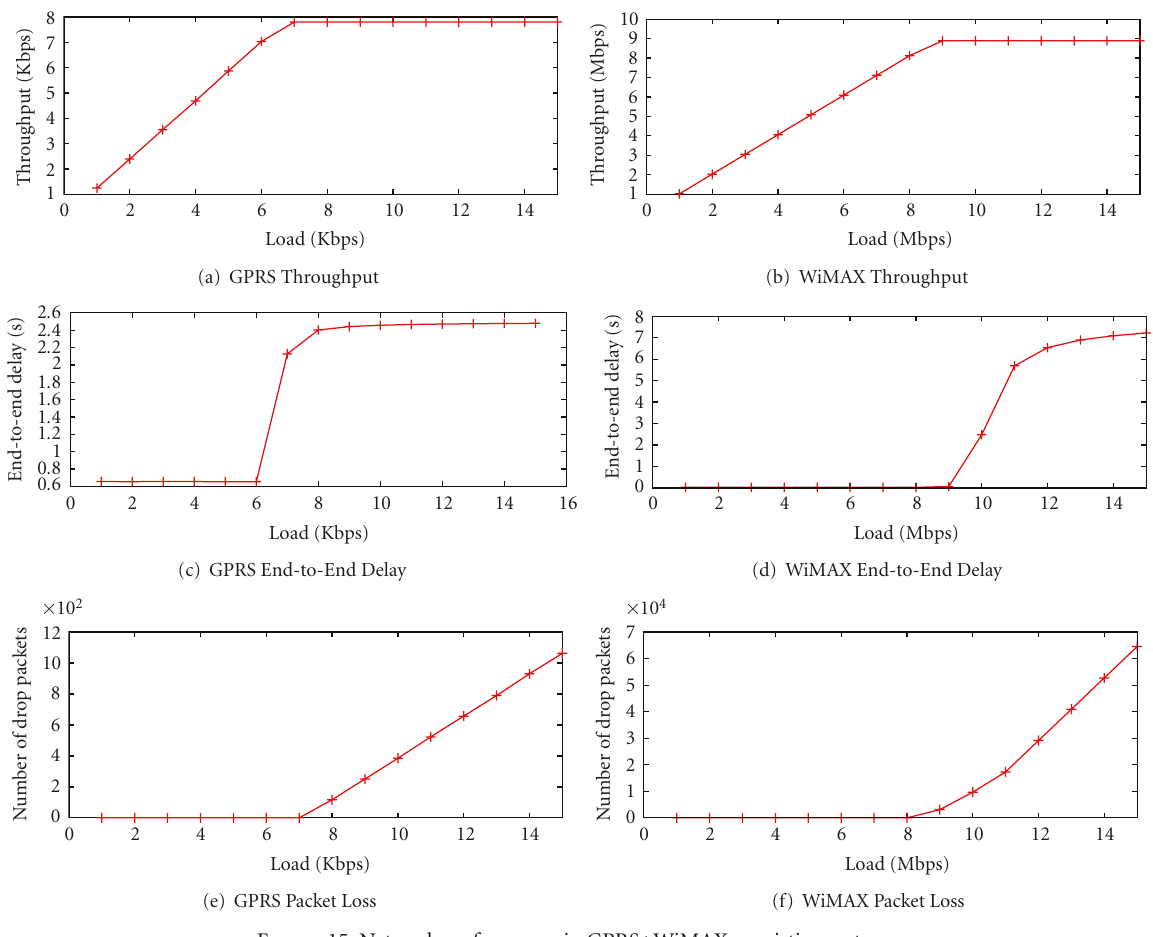
Figure 15: Network performance in GPRS+WiMAX coexisting systems.